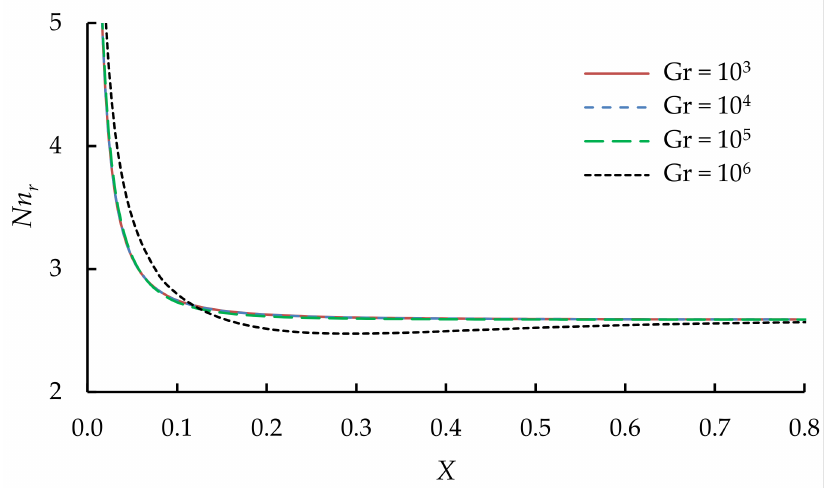
Figure 13. Effect of the Grashof number on the reduced density number of the microorganisms, Nn r , when Re = 400, Pr = 6.2, Le = 10, Nb = Nt = Nr = Rb = Ω = 0.1, and Pe = Lb =